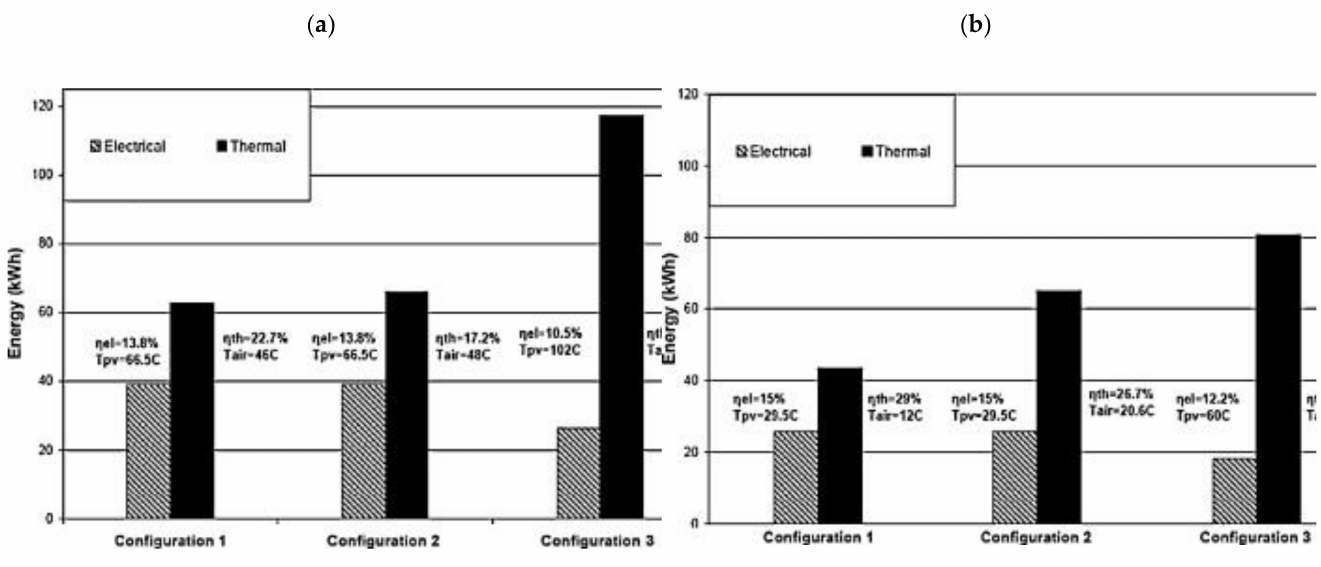
Figure 29. ( a ) Electrical and thermal efficiency of BIPVT in summer; ( b ) electrical and thermal efficiency of BIPVT in winter (reprinted from [137], with permission from